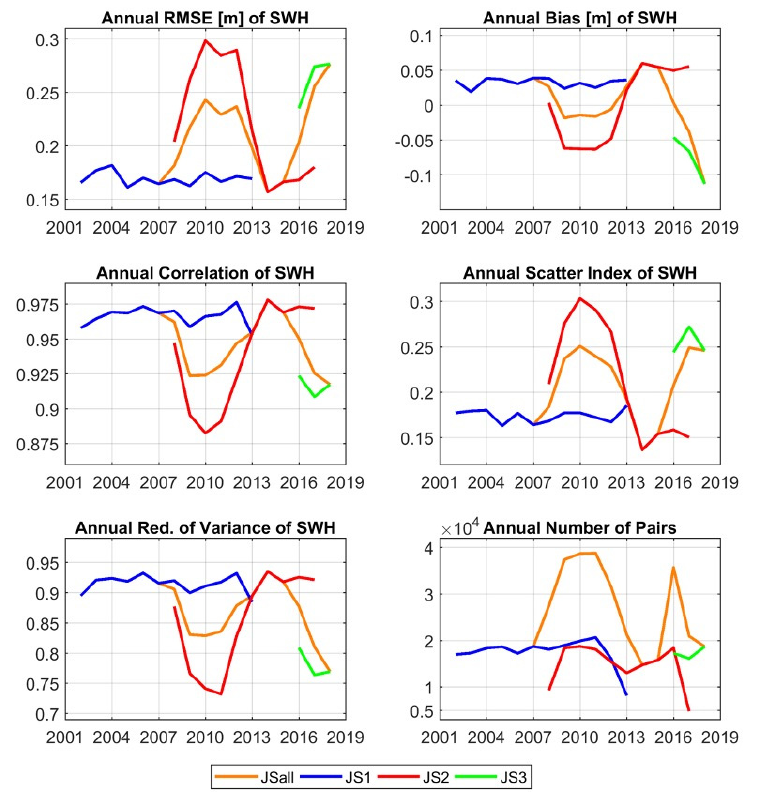
Figure 15. Yearly values of significant wave height metrics (using the BS-WAV MY system) for the Black Sea derived from individual and combined satellite Black Sea derived from individual and combined satellite measurements.